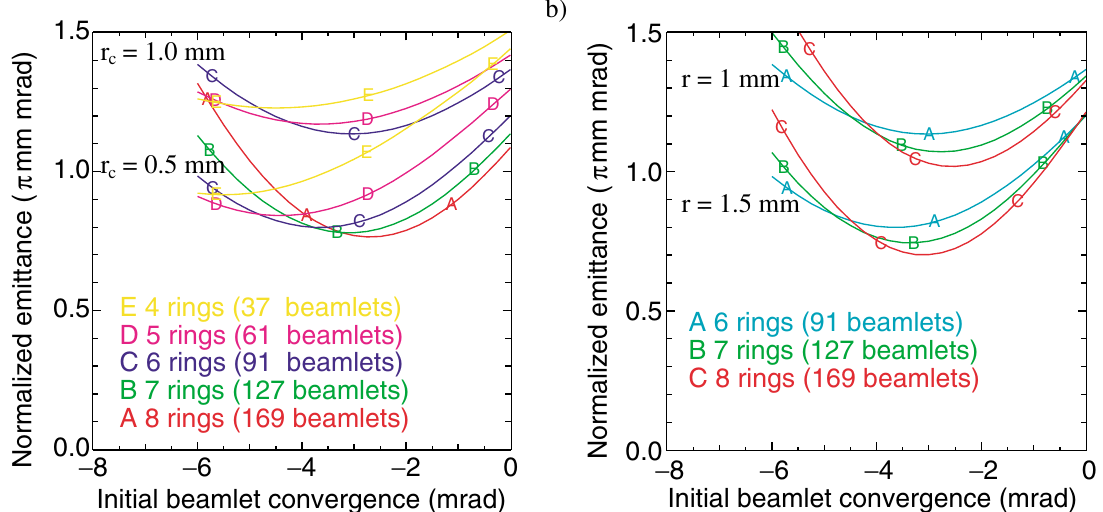
FIG. 6. (Color) Results from simulations with a differing number of